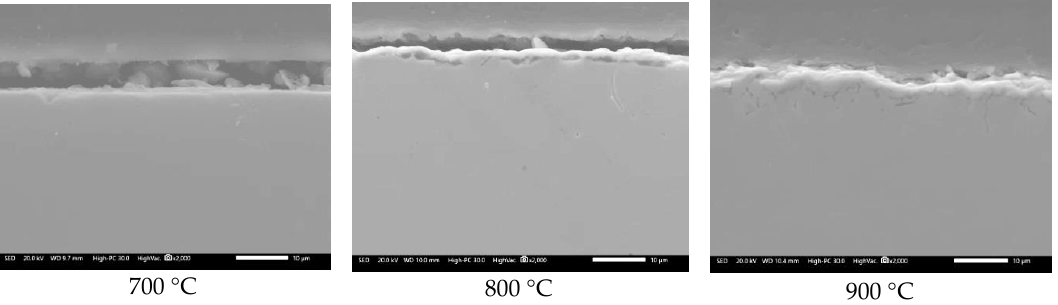
Figure 3. Cross-section aspect of 304H steel after 100 h of oxidation in air.